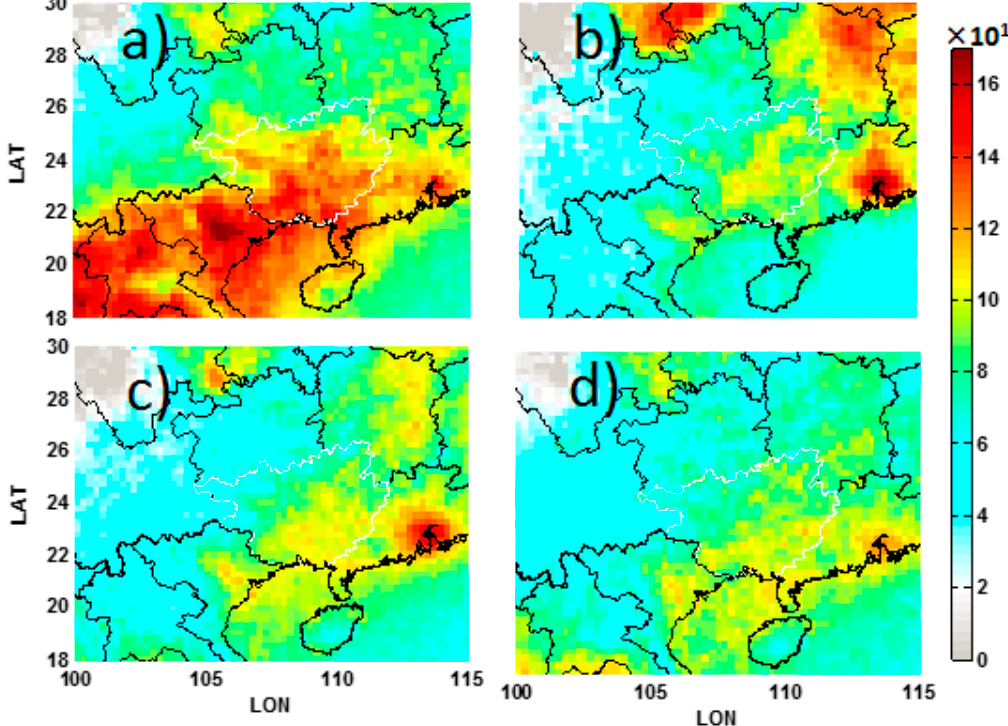
Figure 6. Seasonal-averaged OMI HCHO columns for 2005–2016. ( a ) MAM; ( b ) JJA; ( c ) SON; ( d ) DJF.